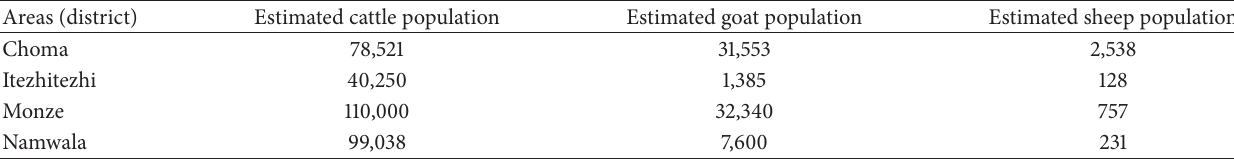
Table 1: Study areas with estimated livestock populations in the study districts (2006).